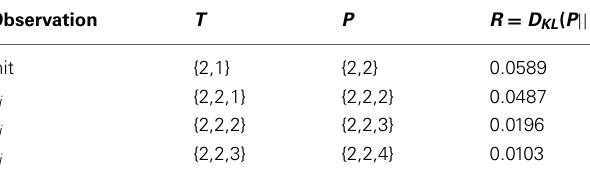
Table 3 | A predictable action ends in a surprising state.